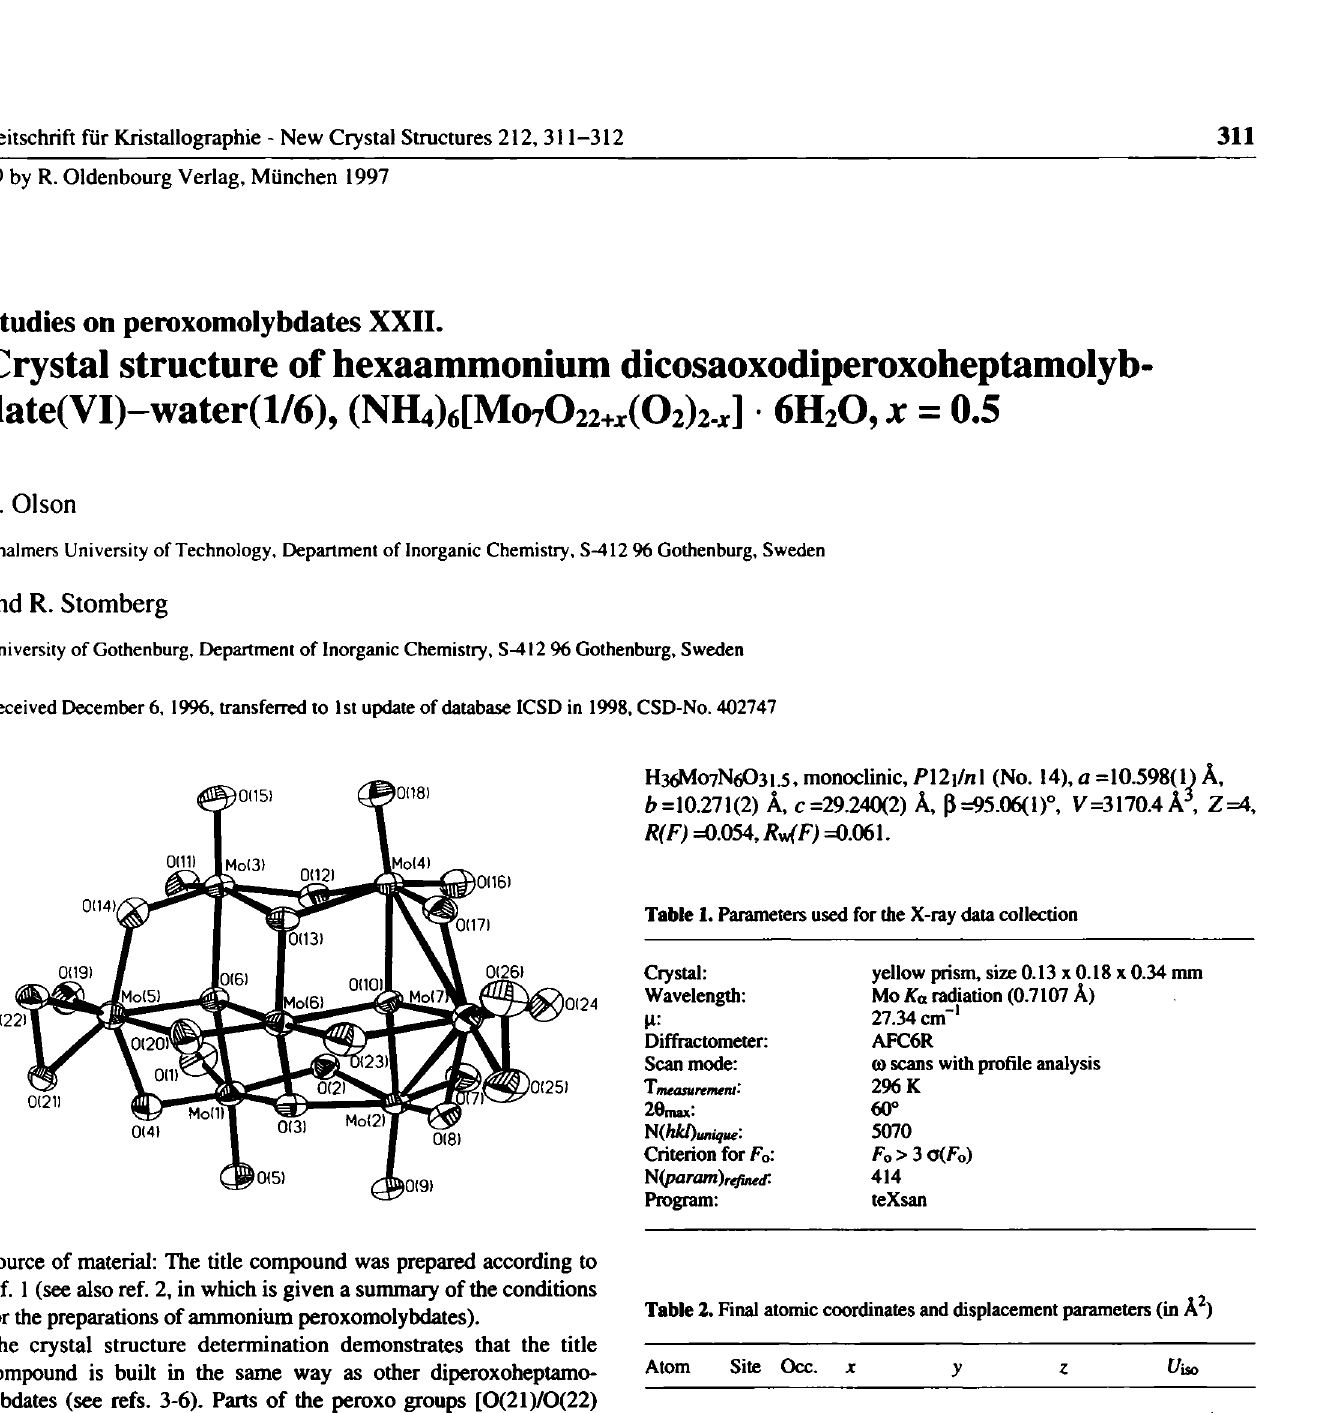
Table 2. Final atomic coordinates and displacement parameters (in Â 2 )